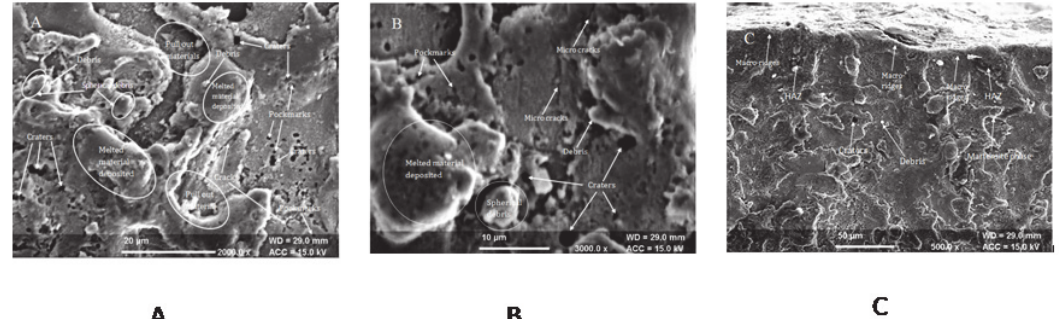
Fig. 8. SEM Micrograph of A 4 B 1 C 1 D 5 E 4 F 2 WEDM-cut surface of Inconel 825 at different cross